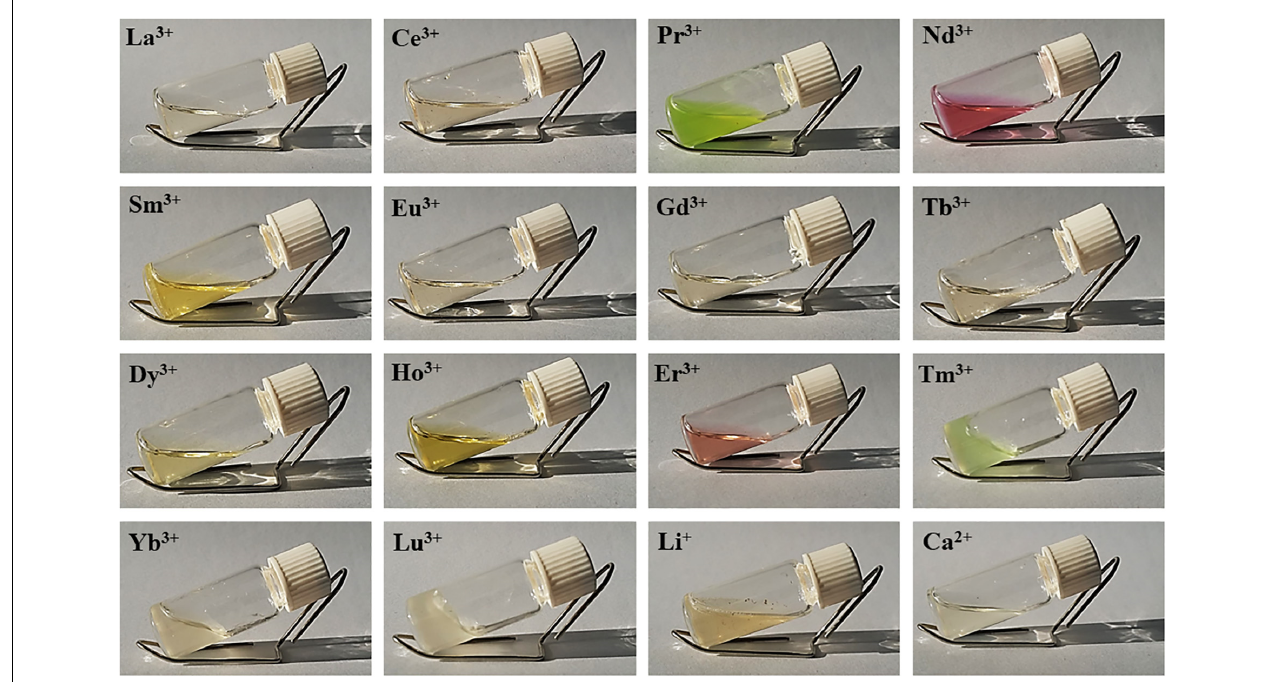
FIGURE 1 | Solutions of degummed SF dissolved in hydrated LnCl 3 /H 2 O/EtOH (1:8:2). The picture of SF dissolved in LiBr 9M in H 2 O and CaCl 2 /H 2 O/EtOH (1:8:2) (standard Ajisawa’s solvent) is also reported.